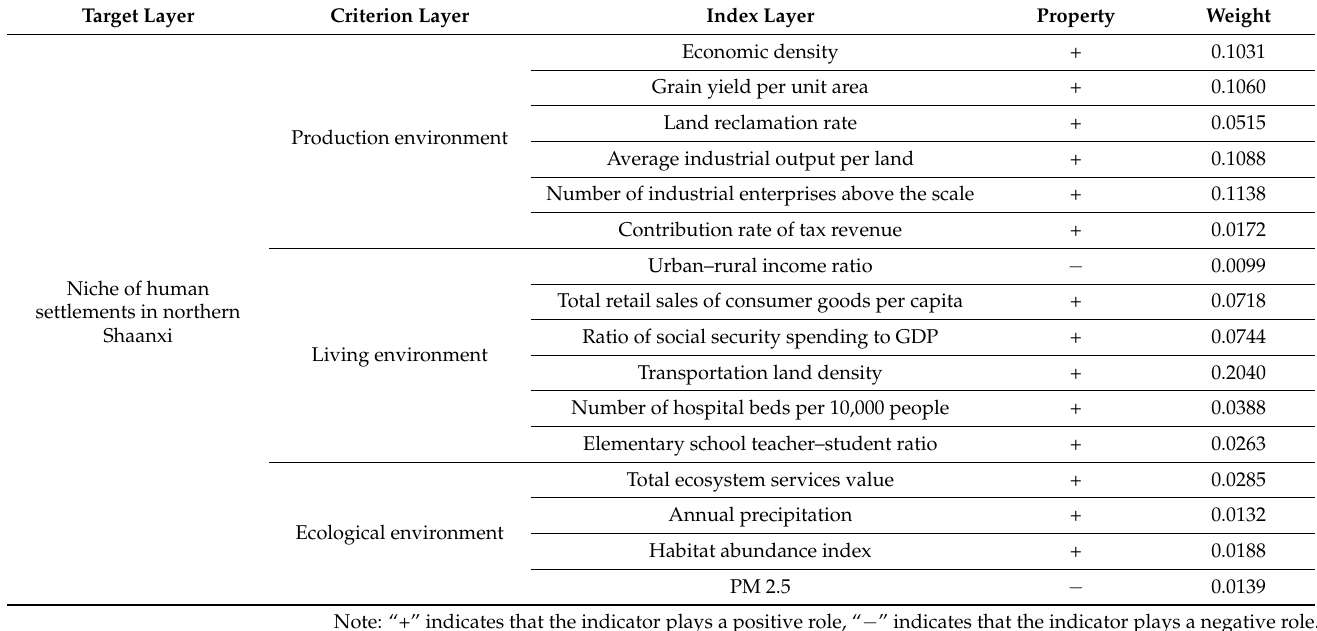
Table 1. Evaluation index system of the niche of human settlement